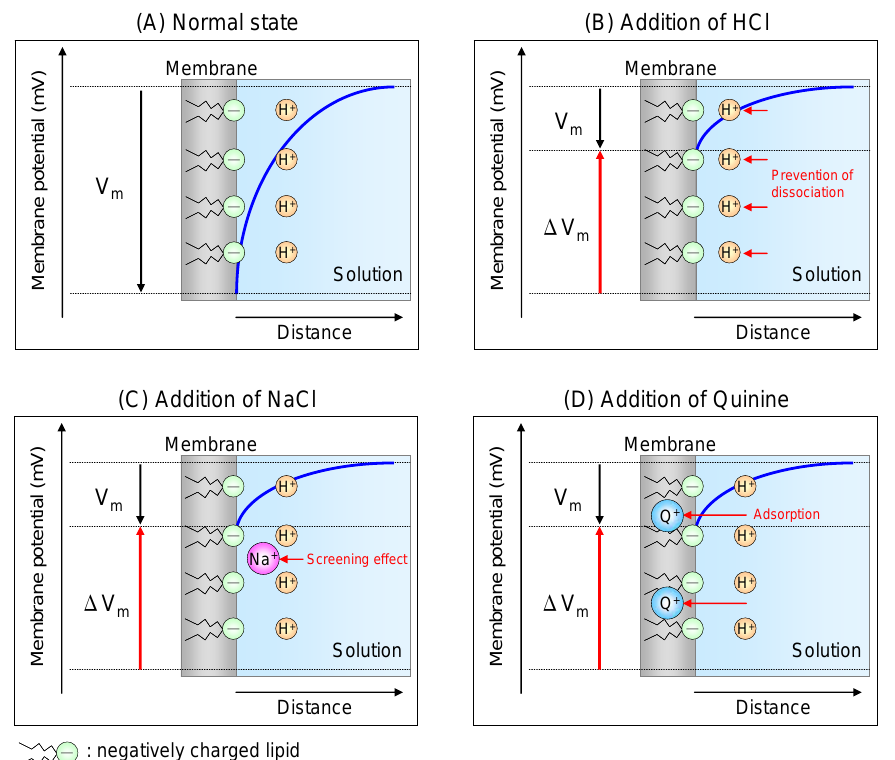
Figure 5. Diagram of response mechanisms of negatively charged membrane to sour, salt, , membrane potential; Δ V , change in membrane potential and bitter taste substances. V m m (sensor output); H + , proton dissociated from lipid molecule; Na + , sodium ion; Q + , quinine ion. The blue curve represents the change in electrical double layer with